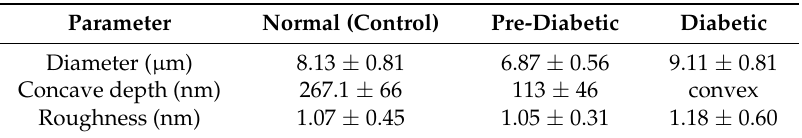
Figure 1. Images of erythrocytes of a normal ( A ) and pre-diabetic ( B ) individual by AFM (atomic force microscopy). ( C ) Geometrical profiles of the healthy control erythrocyte and ( D ) pre-diabetic erythrocyte. These cells are a representative of 20 smears. The diameter of the control cells is 8.13 ± 0.81 µ m, and the diameter of diabetes cells is 6.87 ± 0.56 µ m. The concave depth of pre-diabetic cells, 113 ± 46 nm, is only half of that of control cells, 267.1 ± 66 nm. Scan size = 10 × 10 µ m. Also note the distinct, balloon-like structure of the RBC of the diabetic patient ( E ); the next important feature is the clinging and clustering of cells among themselves ( F ). Table 1. Statistical analysis of some erythrocyte parameters of the pre-diabetic, diabetic, and healthy individuals with significance p <